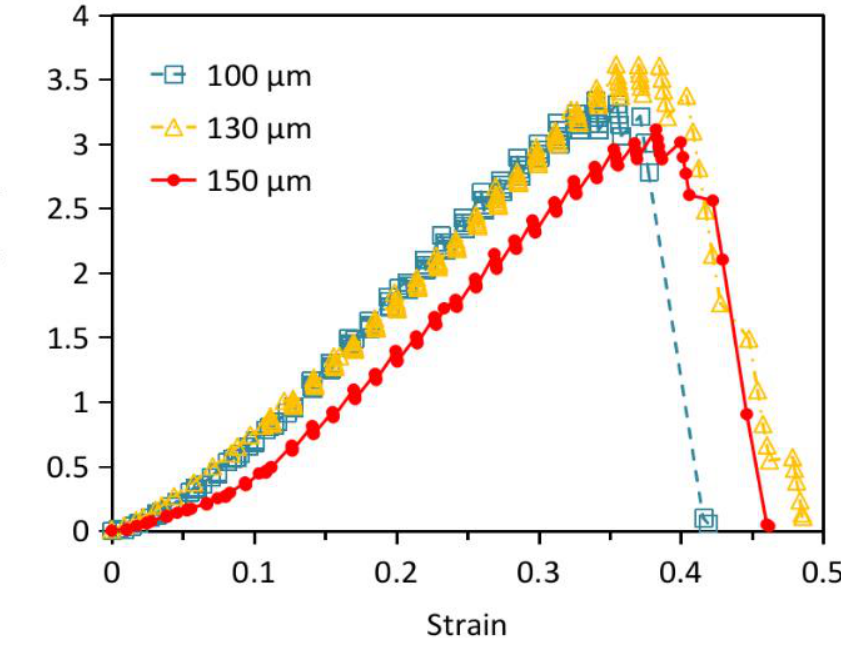
Figure 10. Compressive load-displacement relations to failure of the micro-lattice structures with different unit cell lengths.